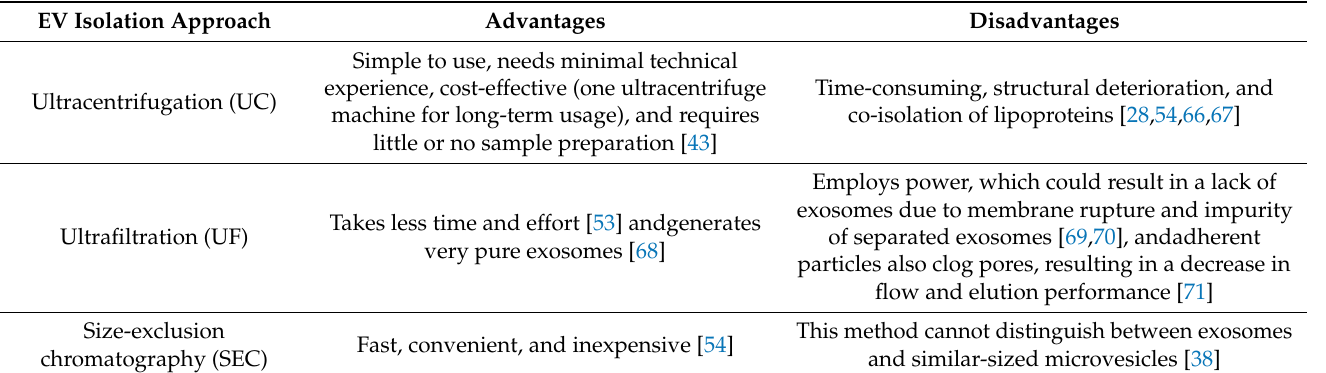
Table 1. Advantages and drawbacks of EV isolation